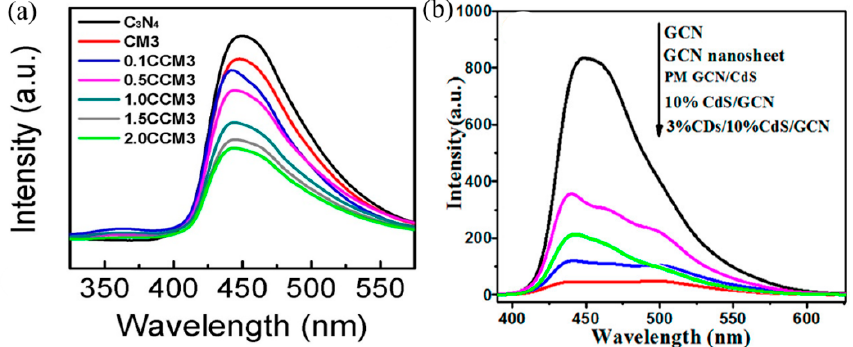
Figure 10. Photoluminescence (PL) emission spectra of ( a ) g-C 3 N 4 , (1–10%) MoO 3 /C 3 N 4 composites, and 0.5CCM3 at an excitation wavelength of 300 nm, ( b ) GCN, GCN nanosheets, PM CdS/GCN, 10%CdS/GCN and 3%CDs/10%CdS/GCN at an excitation wavelength of 325 nm (reproduced with permission from [100,105]. Copyright Elsevier, 2018; American Chemical Society, 2018; respectively).